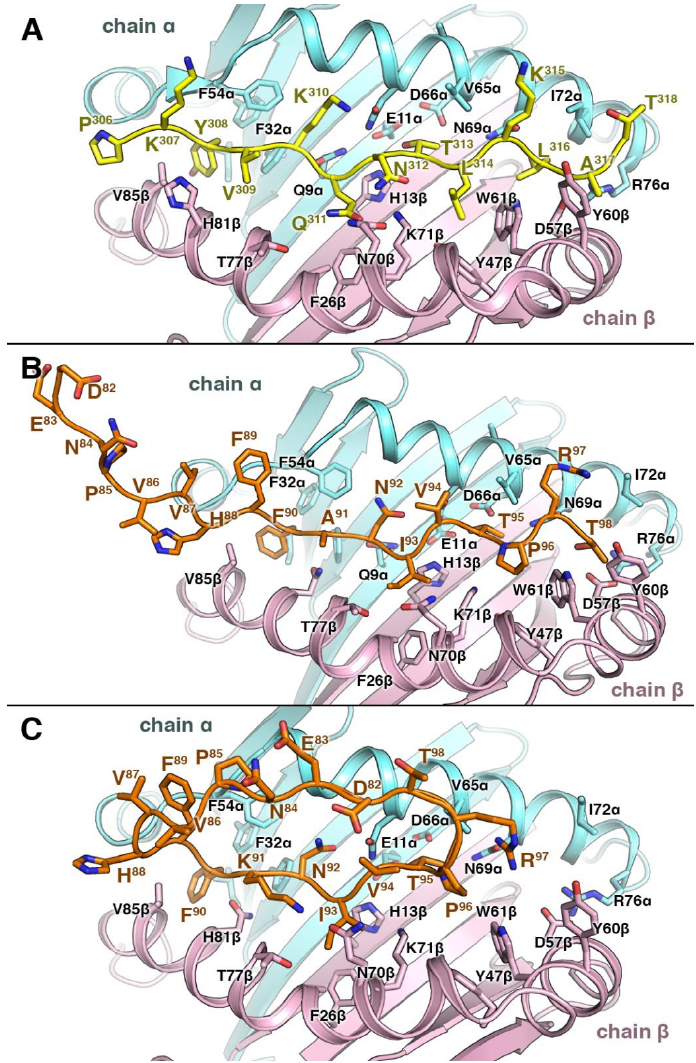
Figure 6. ( A ) Crystal structure of HA 306 – 318 bound to HLA-DRB1*0401 (pdb code 1j8h). The peptide is shown in yellow cartoon representation and sticks (side chains), while chains α and β are depicted in cyan and pink cartoon, respectively. ( B ) Model for the binding of linear MBP 82 – 98 (A 91 ) and ( C ) cyclic MBP 82 – 98 to HLA-DR4. MBP peptides are shown in orange cartoon representation.